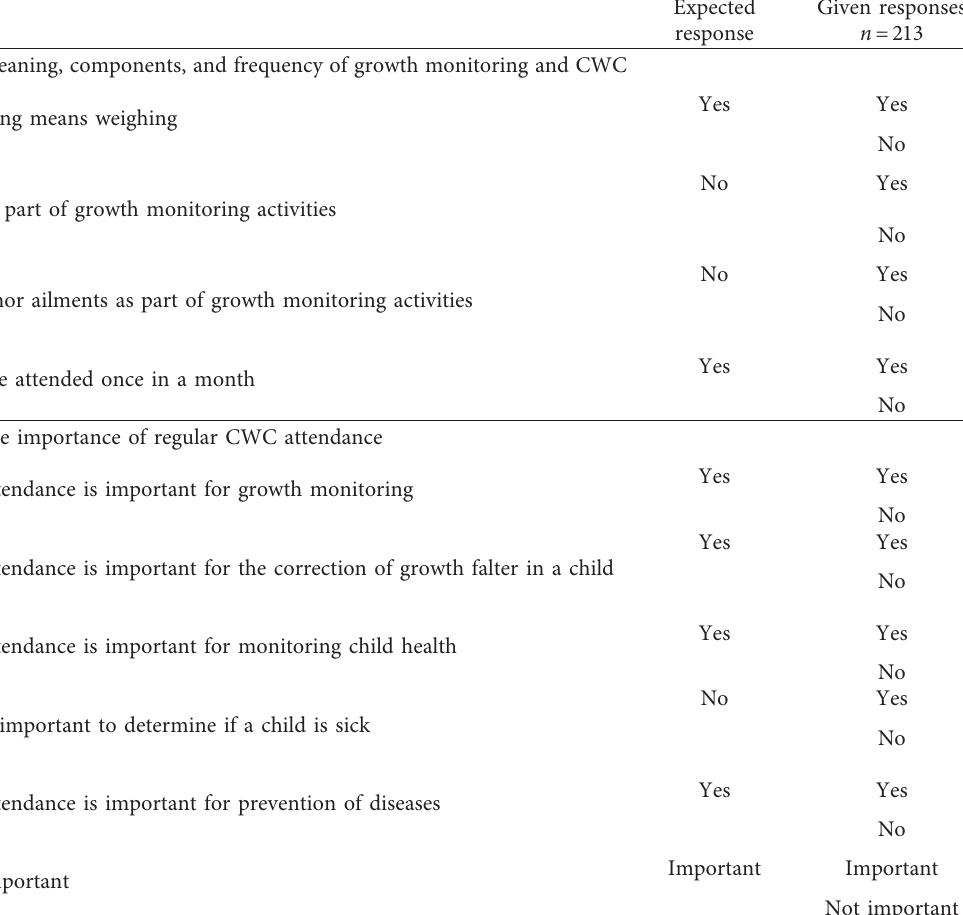
Table 1: Knowledge of caregivers on